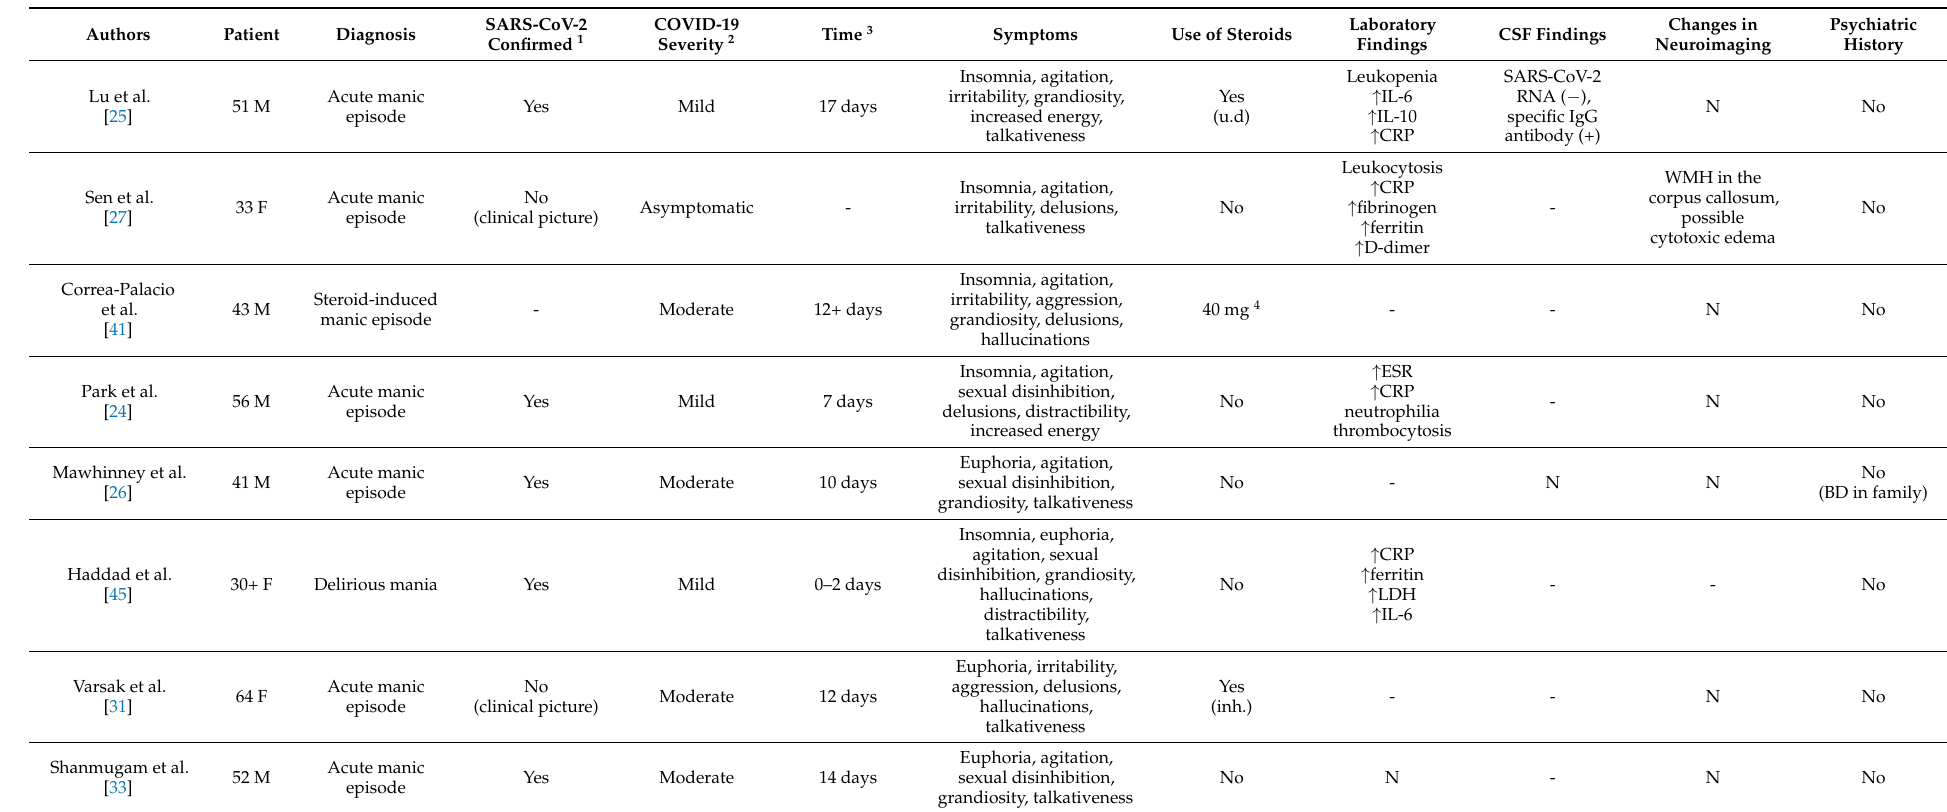
Table 1. Cases of (hypo)mania related to COVID-19. Abbreviations: ↑ —increase; ↓ —decrease; ( − )—negative; (+)—positive; (l.d.)—low dose; (u.d.)—unknown dose; N—normal/no change; —-results not available; M—male; F—female; BD—bipolar disorder; CRP—C reactive protein; CSF—cerebrospinal fluid; ESR—erythrocyte sedimentation rate; IL-6—interleukin-6; IL-10—interleukin-10; inhaled steroids; K + —potassium ions; LDH—lactate dehydrogenase; PTSD—post traumatic stress disorder; SLE—systemic lupus erythematosus; WMH—white matter